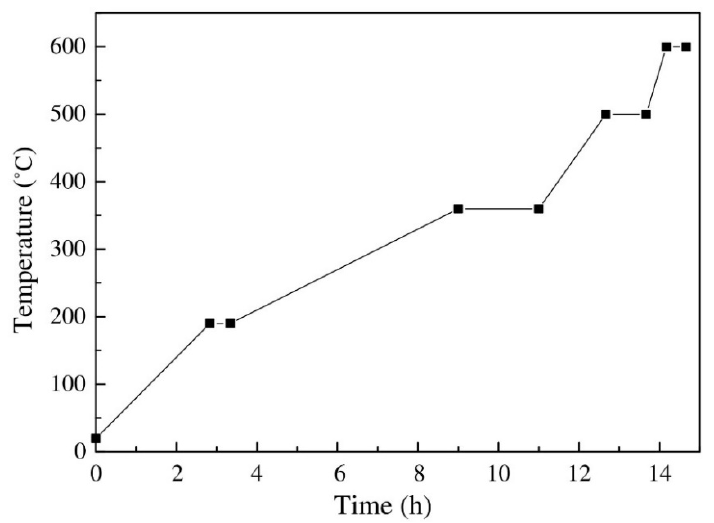
Figure 11. Debinding cycle of 14.5 h to remove EVA and LDPE. Reproduced with permission from reference [97], copyright © 2004 Elsevier Ltd.